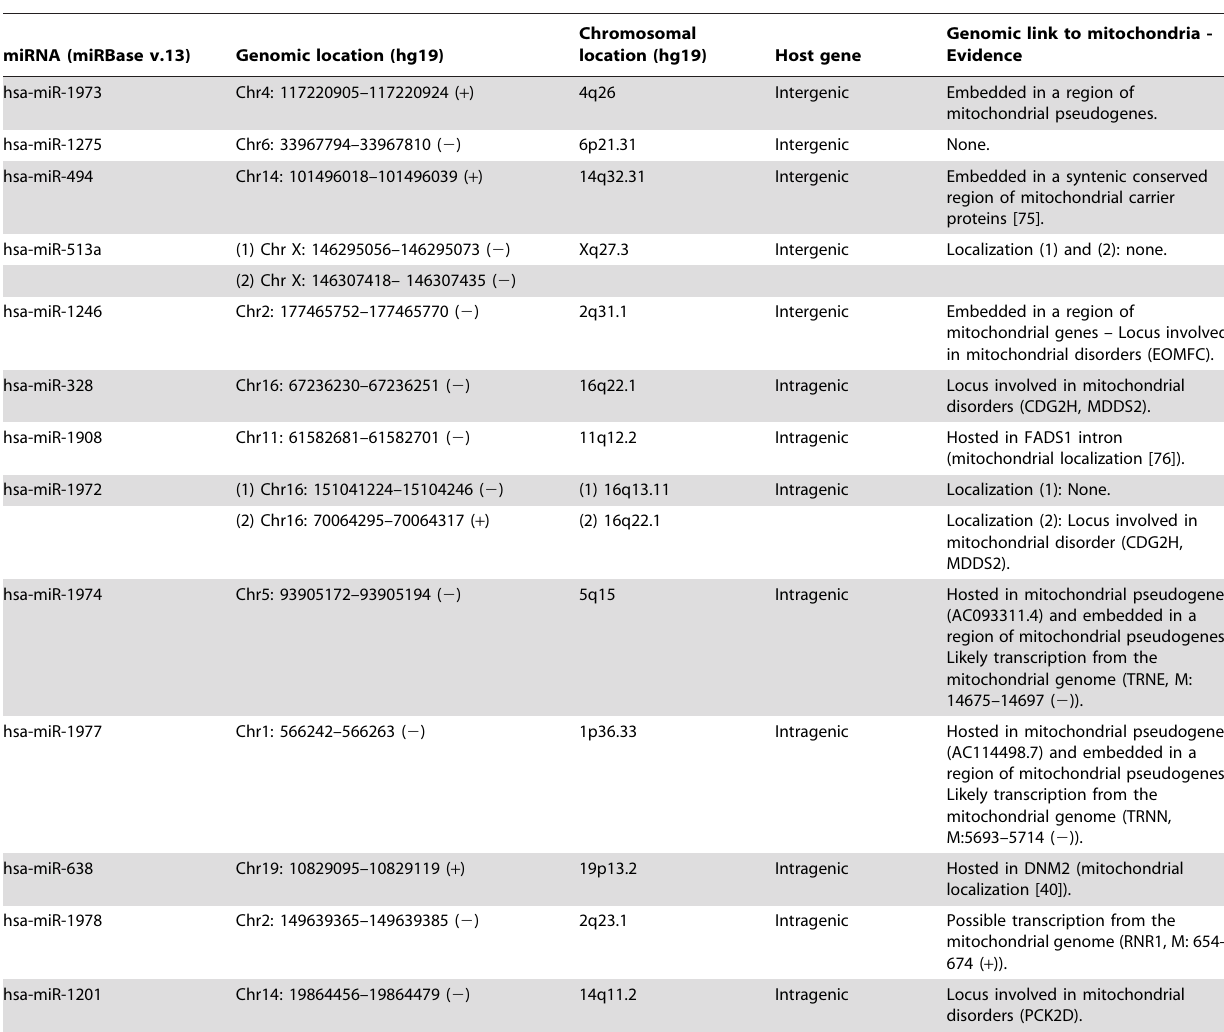
Table 3. Genomic and chromosomal locations of mitomiRs.